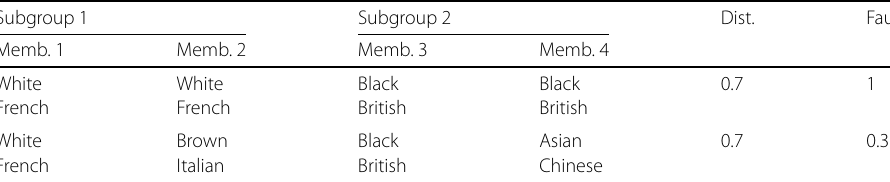
Subgroup 1 Subgroup 2 Dist. Memb. 1 Memb.